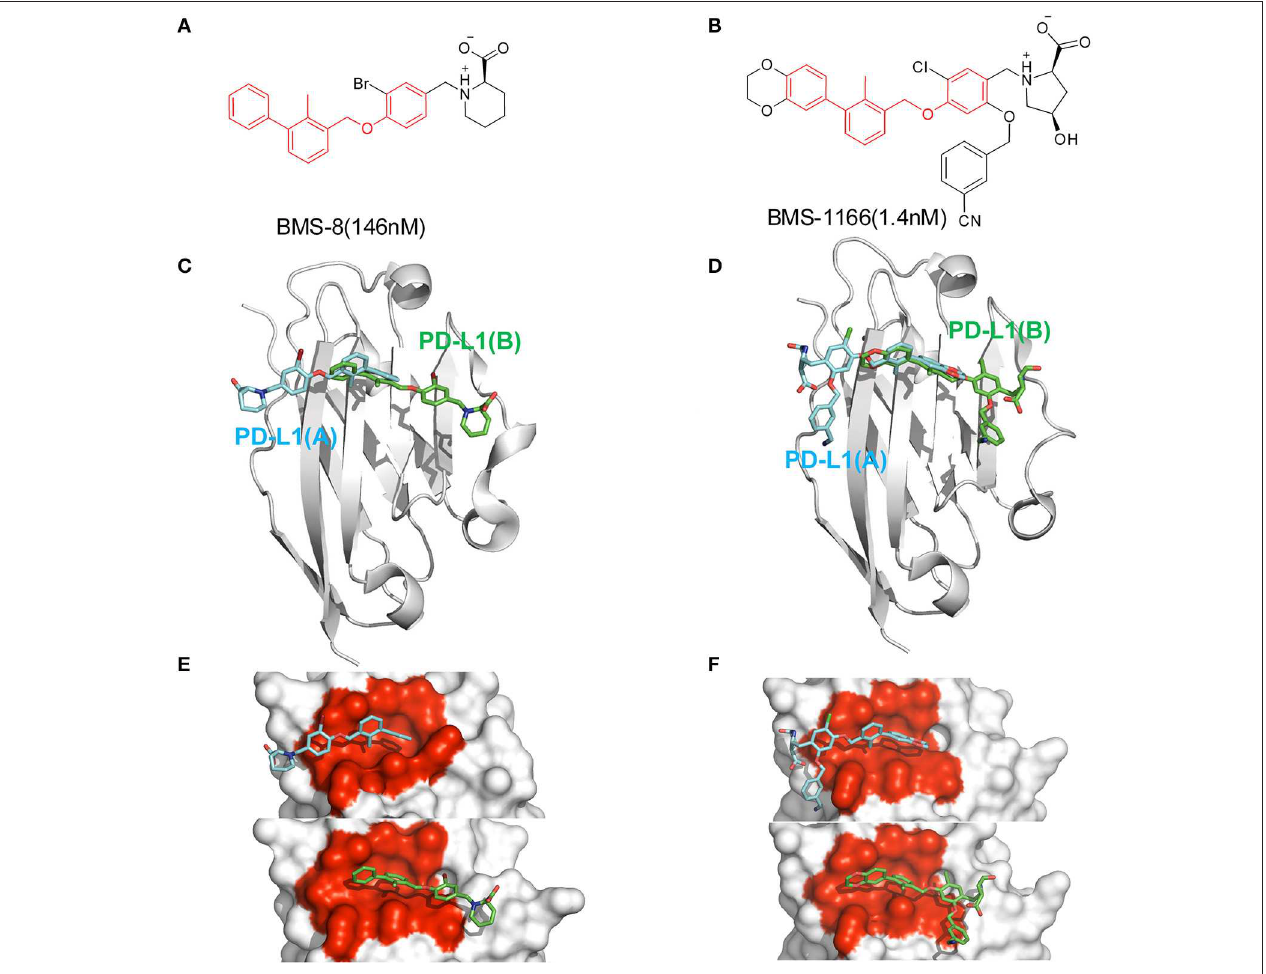
FIGURE 1 | The structural information of BMS-8 and BMS-1166. (A,B) The chemical formulas of BMS-8 and BMS-1166. The core scaffold is colored in red. (C,D) The conformational superposition of BMS-8 and BMS-1166 interacting with the monomer conformation A, B of PD-L1. (E,F) The surface of PD-L1 (A) and PD-L1 (B) interacting with BMS-8 and BMS-1166. The binding pockets formed by I54, V55, Y56, M115, I116, S117, A121, D122, and Y123 were colored in red.